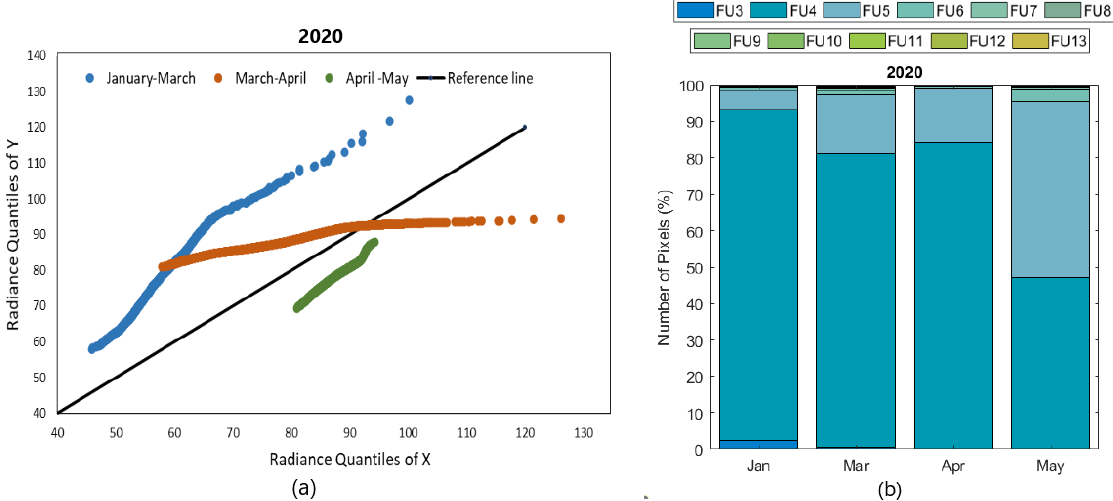
Figure 7. Comparison of B2 radiance (Top of Atmosphere Reflectance) and FUI for months January, March, April, and May in year 2020. ( a ) Q–Q plot for B2 radiance (X: Previous month image, Y: Current month image); ( b ) Stacked bar chart showing FUI (number of pixels